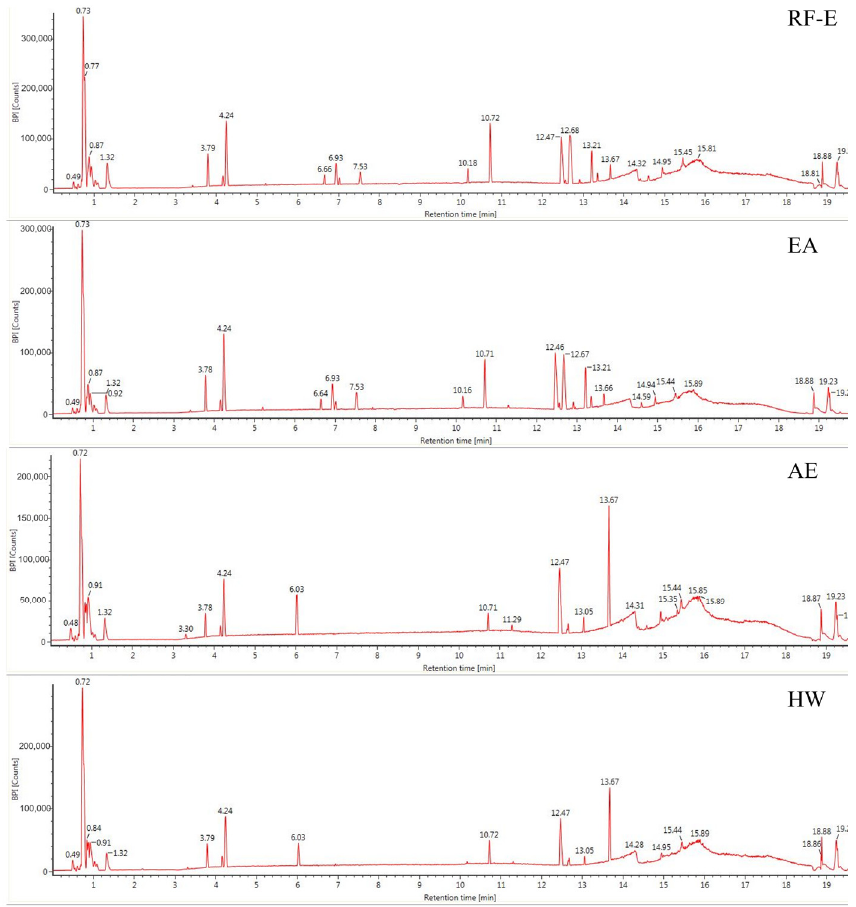
Figure 2. Base peak chromatograms of A. trifoliata flower extracts. See Figure 1 for abbreviations. Generally, the four extraction procedures yielded significant differences in the content of bioactive compounds. Most compounds were more abundant in the RF-E and EA extracts, and isochlorogenic acid levels were 4-fold greater than those in the AE extract and HW extract. In addition, the AE extracts contained the highest levels of quercetin and kaempferol, while the flavonols were more abundant in RF-E extract and EA extract. These results indicated that enzymatic hydrolysis released greater levels of phenolic acids while acidified EtOH preferentially extracted flavonoids as shown by TFC and TPC values (Figure 1A). Similarly, the hydroxycinnamic acid and total non-anthocyanin polyphenol content of RF-E extract and EA extract were higher than those of AE and HW extracts (Table 1). Overall, these results indicated that RF coupled with enzymatic hydrolysis was a reliable method for non-anthocyanin polyphenol extraction that primarily consisted of hydroxycinnamic acids and flavonols. These non-anthocyanin polyphenols are more stable at high temperatures compared with the destructive effects of heat on A.